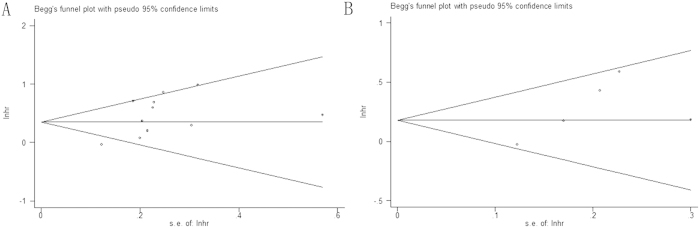
Begg’s funnel plot of publication bias test for (A) OS and (B) DFS/PFS in NSCLC.